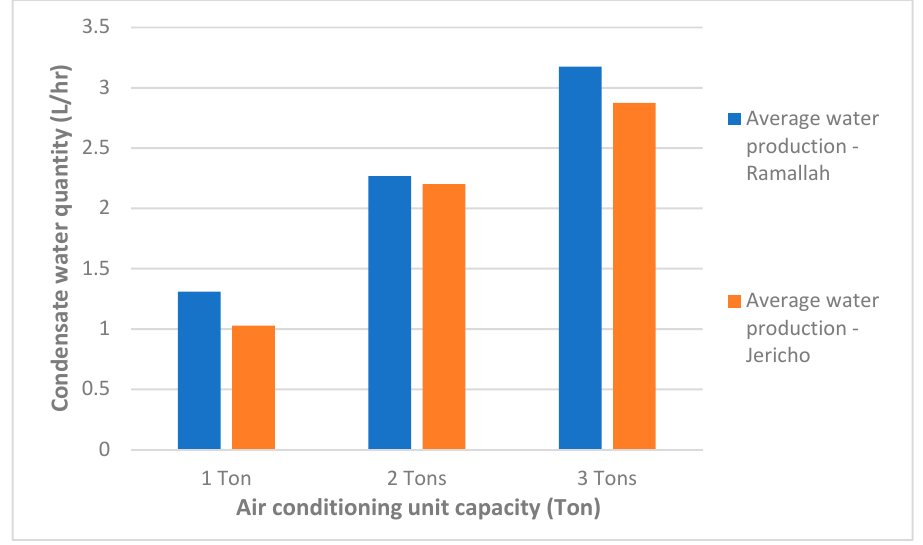
Figure 7. Quantities of condensate water at 18 °C operating temperature in Ramallah and Jericho cities.